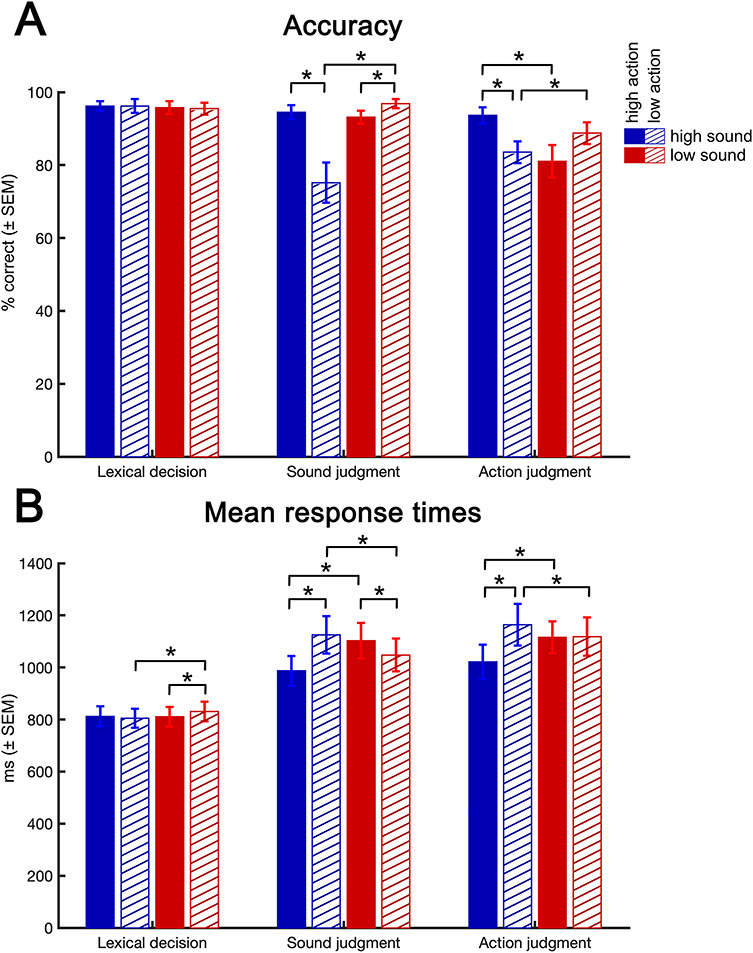
Behavioral results. (A) Accuracy is shown in percent correct responses. (B) Mean response times for correct trials are given in ms. Error bars represent standard error of the mean (SEM). *P < 0.05 (Bonferroni-Holm corrected).